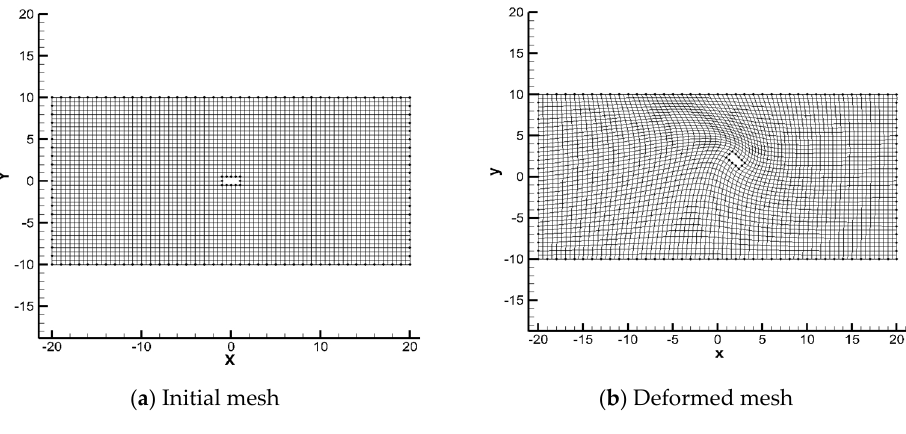
Figure 2. Mesh of test case